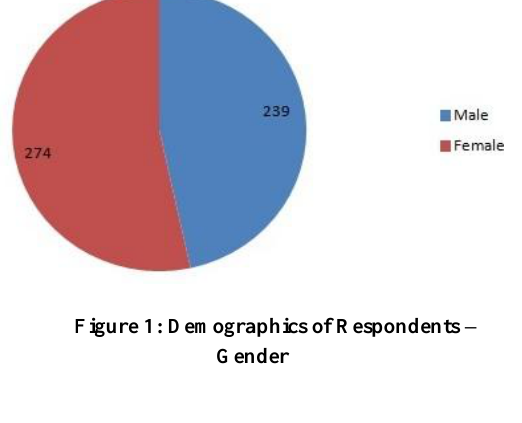
Figure 1: Demographics of Respondents – Gender